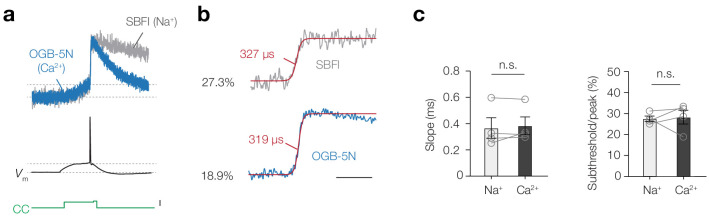
AP-evoked Ca2+ and Na+ entry follow identical kinetics.(a) Neurons were co-loaded with OGB-5N (1 mM) and SBFI (1 mM) indicators to acquire Ca2+ (blue) and Na+ (grey) signals from the same AIS region at a rate of 20 kHz. The current-clamp step protocol (green) consisted of a 50 ms subthreshold square pulse followed by a brief 5 ms pulse at the end triggering an AP. Both subthreshold and AP evoked signals are visible for [Ca2+]i and [Na+]i. Scale bar, 500 pA. (b) The example traces from a. fitted with a sigmoidal function (red) with slopes values indicated (red). The percentages indicate the subthreshold-activated fraction of ion flux (ΔF/F prior to the AP normalized peak ΔF/F). Scale bar, 10 ms. (c) Population data of the rise times and subthreshold/peak ratio difference of Ca2+ and Na+ indicators. Slope, Wilcoxon matched-pairs signed rank test, n = 4, p>0.999, ratio subthreshold to peak, two-tailed paired t-test, n = 4, p=0.83. Open circles and connecting lines represent individual cells and bars show the mean ± s.e.m. Data available in Figure 6—source data 1.